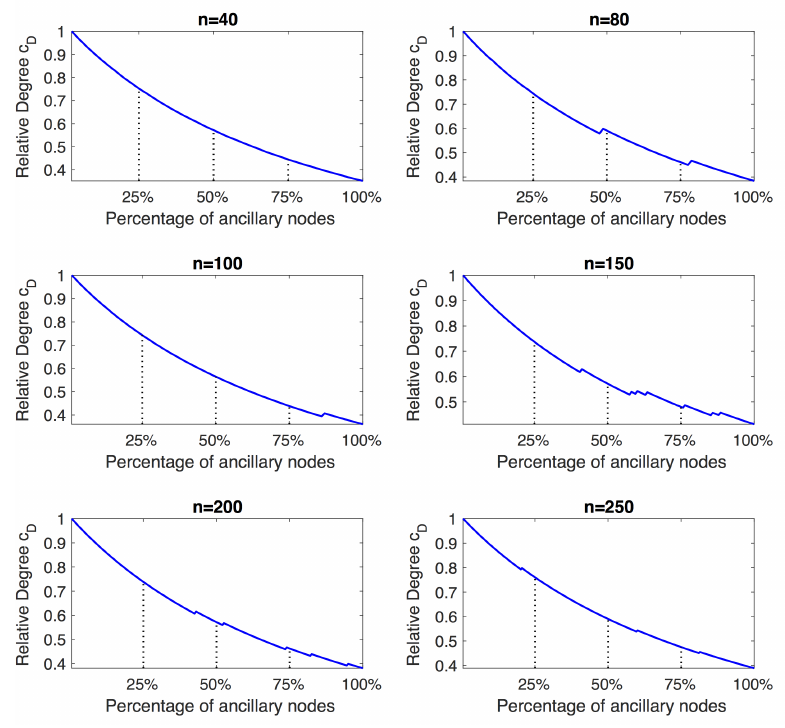
greatest variation is observed with 100% of nodes added, 36% to 50% for C D and C C and 11% to 21% for betweenness C B